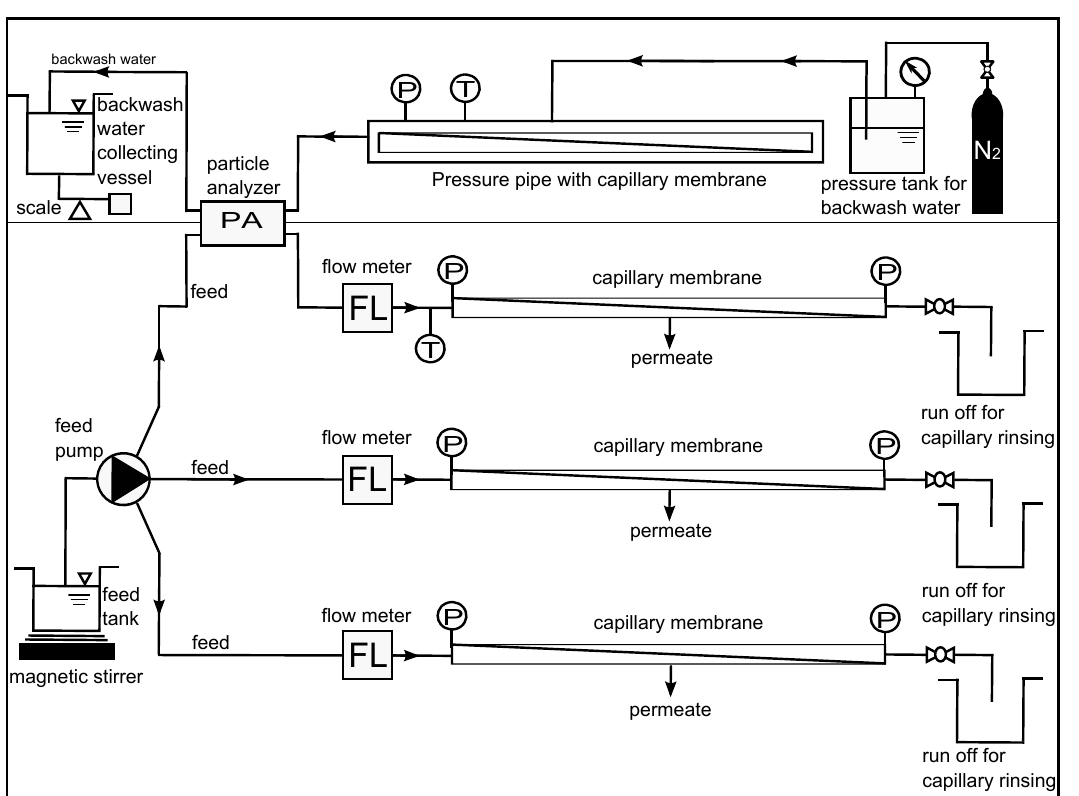
Figure 1. Schematic representation of the filtration and backwash